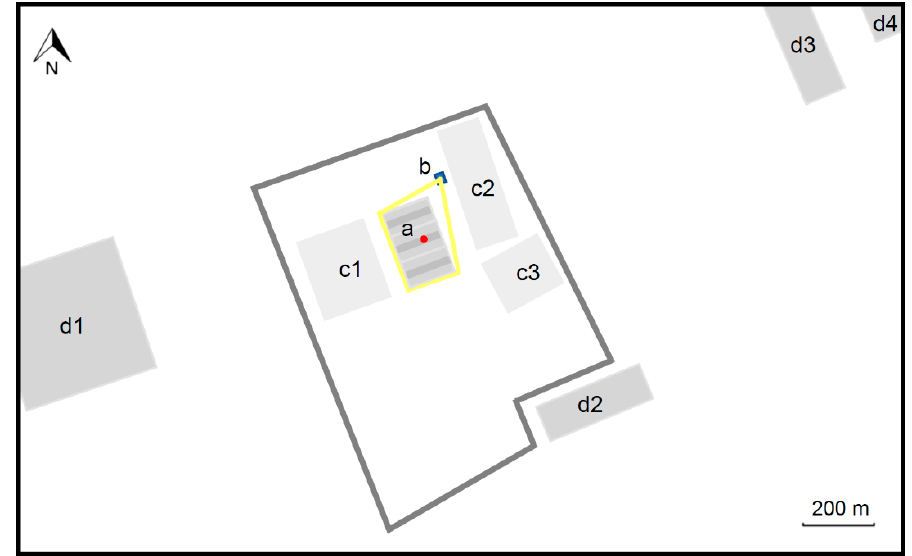
Figure 1. Schematic diagram of the dairy farm and the surroundings. The yellow line stands for the envelope line, the red point stands for the origin; a : Feedlot pens, the brownish area stands for the barns; b : Feed mill; c1 : Office area; c2 : Milking parlour, manure and slurry treatment area; c3 : Research centre; d1–d4 : Surrounding villages.